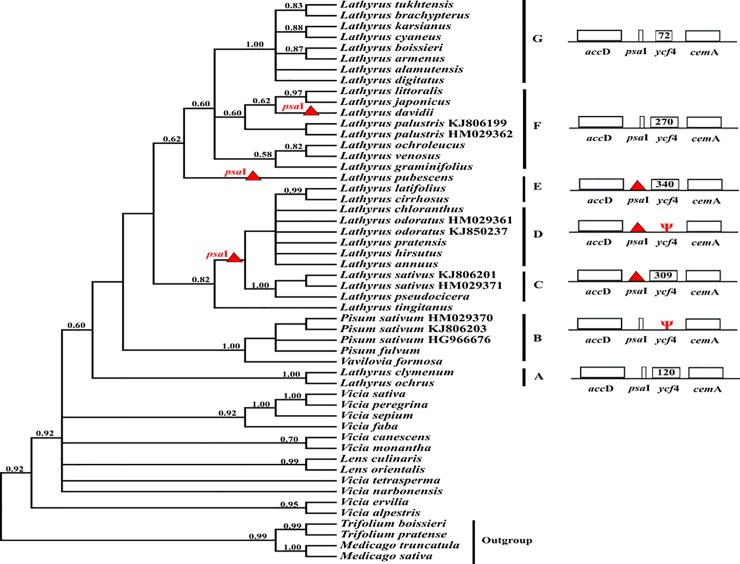
Presence and absence of the ycf4 and psaI genes in Lathyrus, Pisum and Vavilovia.Red triangles on branches indicate evolutionary losses of the psaI gene. Psi symbols denote pseudogenes. Numbers indicate the numbers of codons in ycf4 gene. The topology of the tree is the result of Bayesian analysis of tribe Fabeae based on ycf4 gene. Numbers above branches are posterior probability values. Values <50% were not shown.